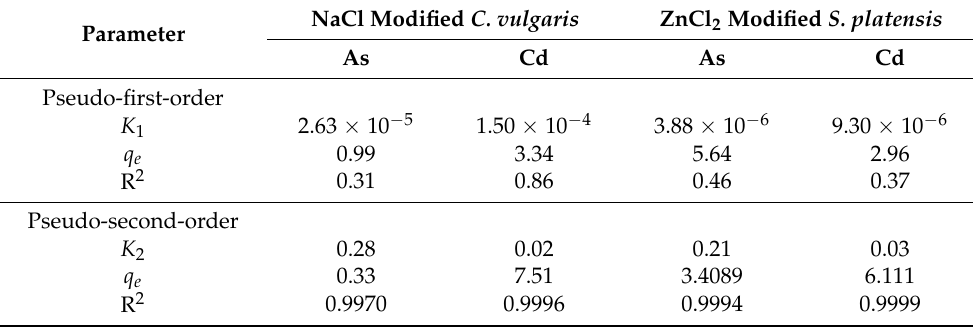
Table 1. Kinetic model parameters of As(V) and Cd(II) biosorption onto the NaCl modified C. vulgaris and S. platensis.